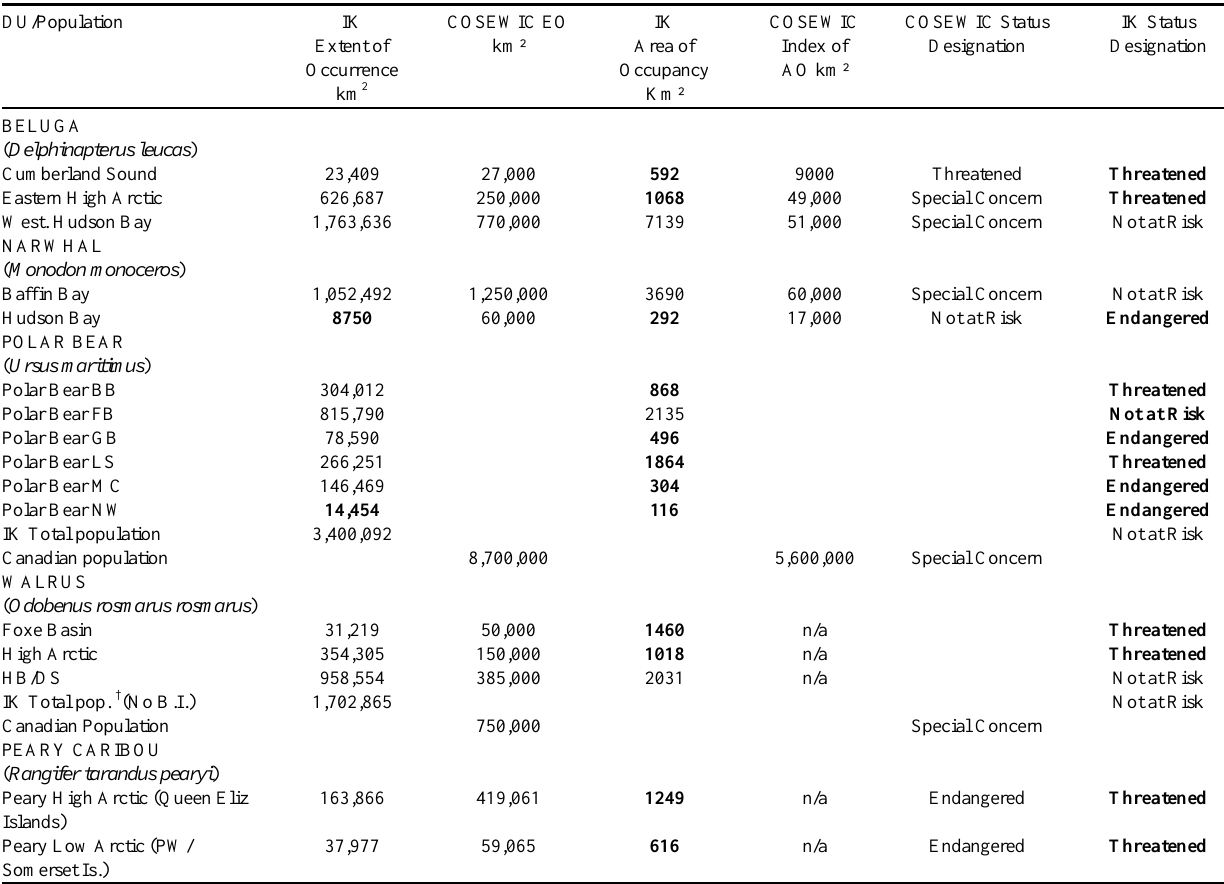
Table 2 . Application of Inuit knowledge (IK) extent of occurrence (EO) and IK area of occupancy (AO) values to Committee on the Status of Endangered Wildlife in Canada (COSEWIC) criteria and comparison with COSEWIC values. See Appendix 1 for glossary of